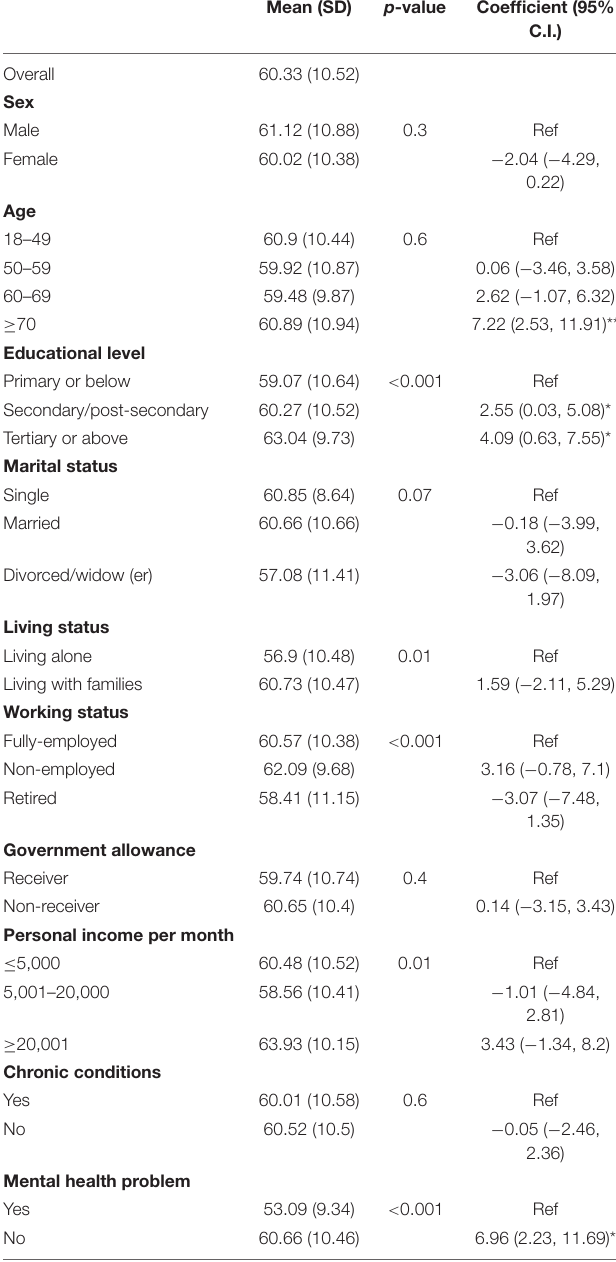
TABLE 7 | Univariable and multiple analysis of the